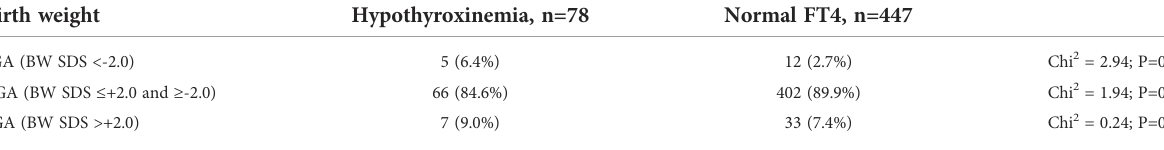
TABLE 2 The incidence of SGA, AGA and LGA among children with hypothyroxinemia and with normal FT4 concentration (SGA, small for gestational age; AGA, appropriate for gestational age; LGA, large for gestational age; SDS, standard deviation score). Birth weight Hypothyroxinemia, n=78 Normal FT4, n=447 SGA (BW SDS <-2.0) AGA (BW SDS ≤ +2.0 and ≥ -2.0) LGA (BW SDS